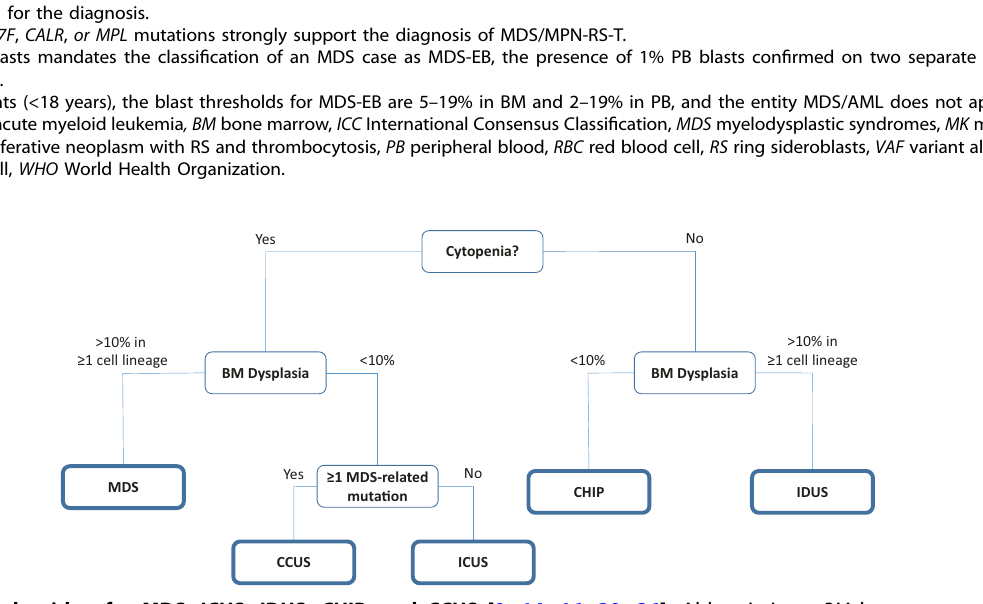
Fig. 1 Diagnostic algorithm for MDS, ICUS, IDUS, CHIP, and CCUS [9, 14, 16, 30, 36]. Abbreviations: BM bone marrow, CCUS clonal cytopenias of uncertain signi fi cance, CHIP clonal hematopoiesis of indeterminate potential, ICUS idiopathic cytopenias of uncertain signi fi cance, IDUS idiopathic dysplasia of unknown signi fi cance, MDS myelodysplastic